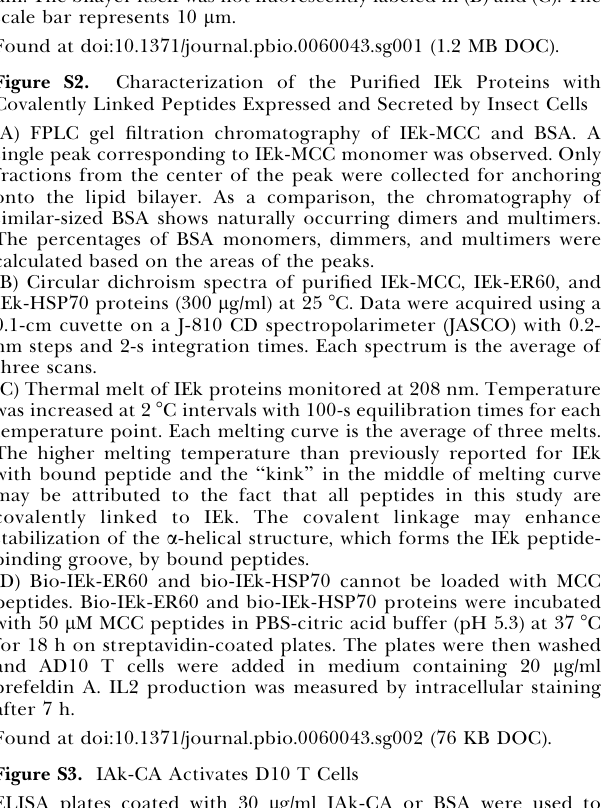
Figure S3. IAk-CA Activates D10 T Cells Figure S4. The Level of bio-IEk-MCC Proteins on the ELISA Plates Used in Figure 3D Was Determined by Binding of SA-HRP